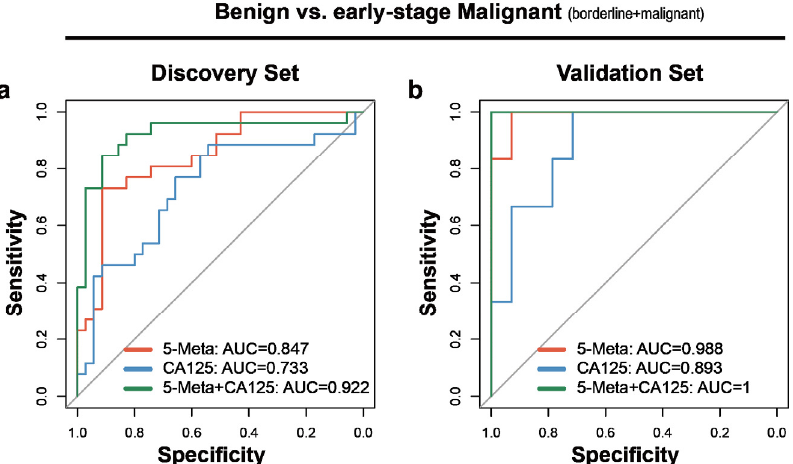
Figure 5. Early-stage diagnostic performance of biomarkers between benign and malignant ovarian tumors in plasma samples. ( a ) The ROC (receiver operating characteristic) curves for comparison between benign versus early-stage ovarian cancer in the discovery set. ( b ) The ROC curves for comparison between benign versus early-stage ovarian cancer in the validation set. AUC = area under the curve. Red line indicates biomarker panel. blue line indicates CA125. Green line indicates the hybrid model based on biomarker panel and CA125.